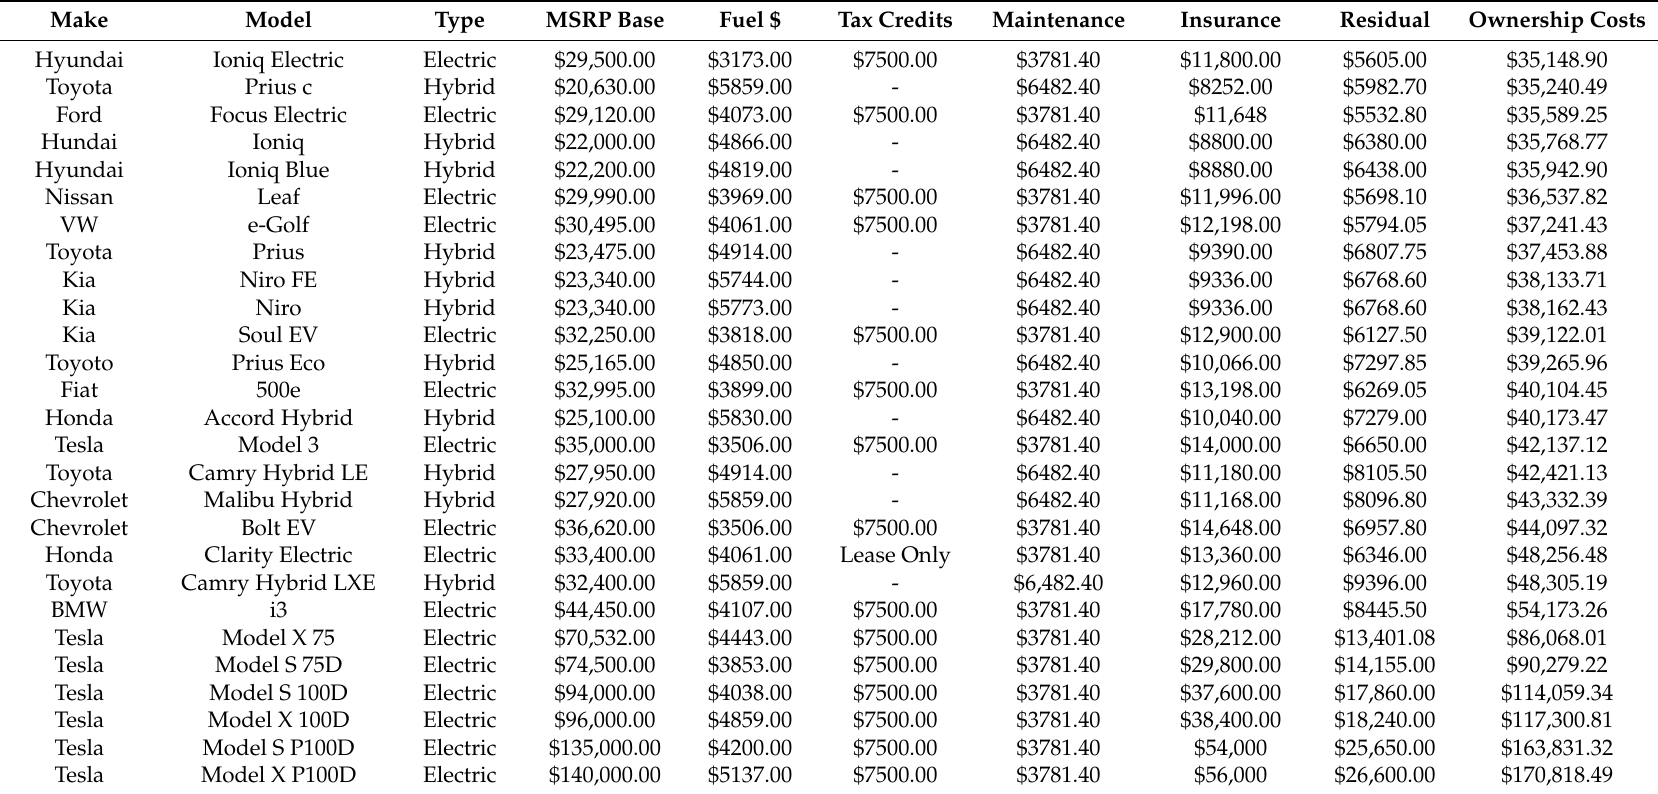
Table 5. Vehicle total costs of ownership (8-year lifespan) from least expensive to most